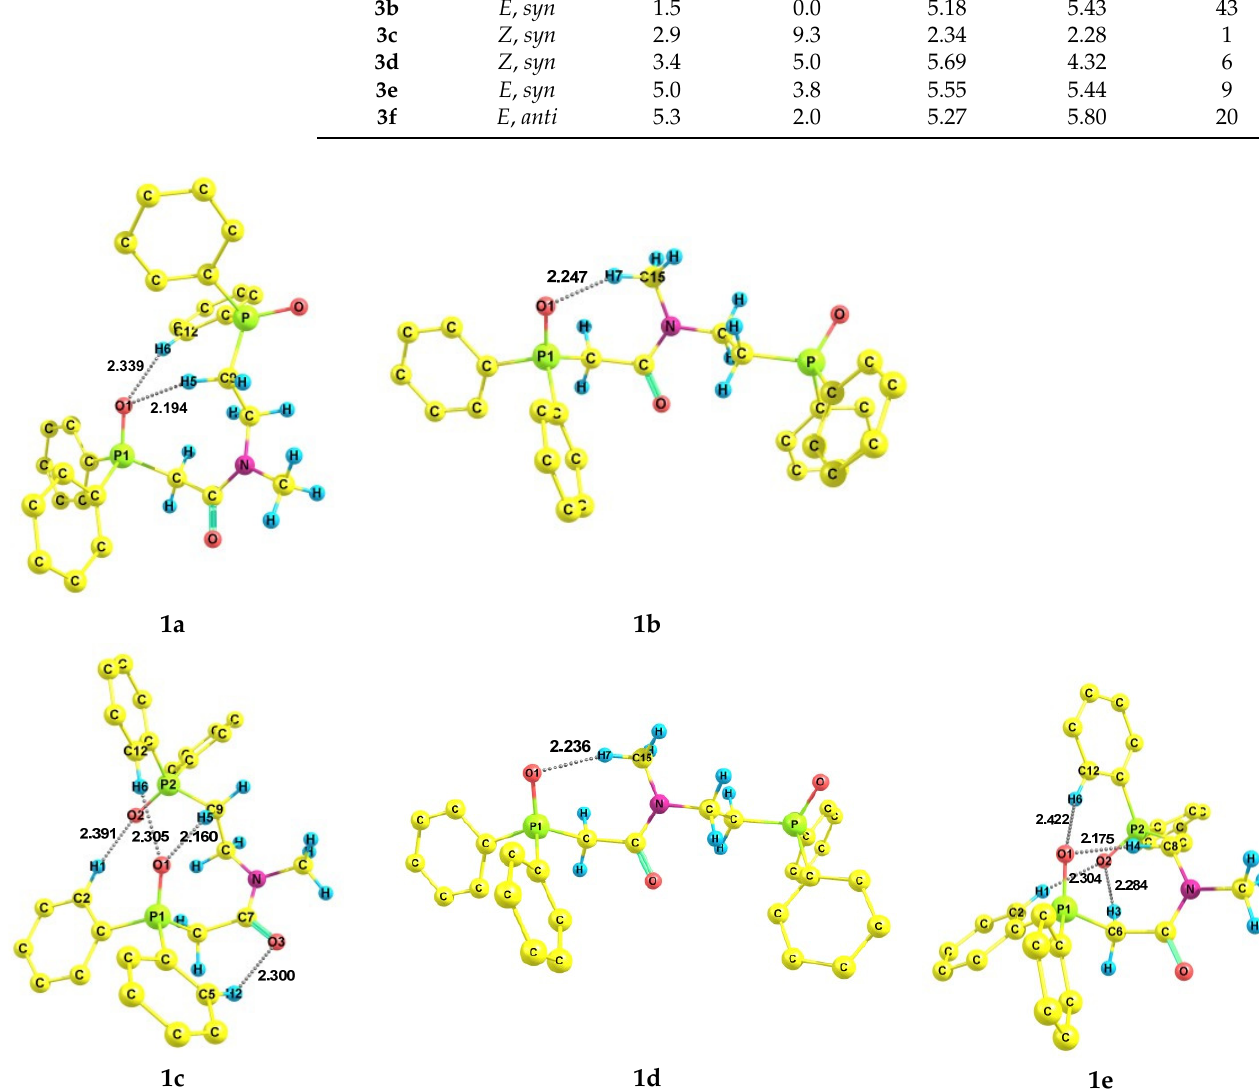
Figure 1. Preferred conformers of 1 according to DFT calculations (some hydrogen atoms are omitted). Distances are given in Å. The amide fragment is flat, the carbonyl and methyl groups have Z -orientation rel- ative to the C sp2 ‒ N bond in conformers 1a , 1c , 1e , and E -orientation in 1b and 1d ; the bulky diphenylphosphoryl fragments are syn -located relative to amide plane in con- formers 1a ‒ 1c and anti -located in 1d and 1e (Figure 1).